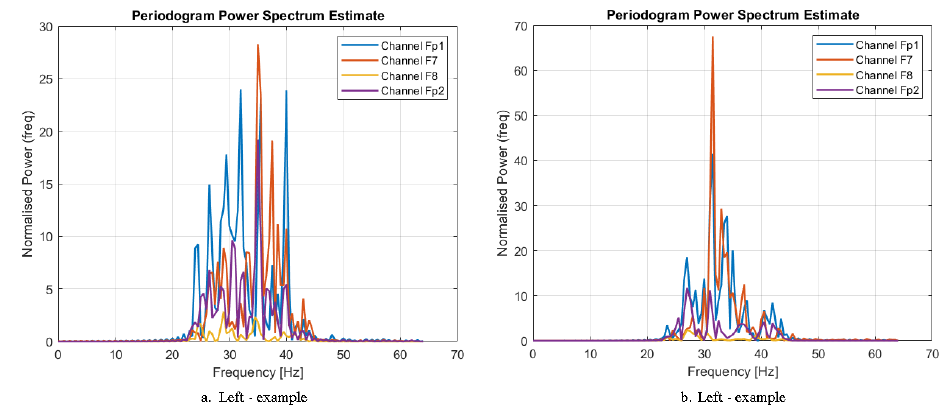
Figure 9. An example of the power spectrum estimation result for participants 7 and 8—left.